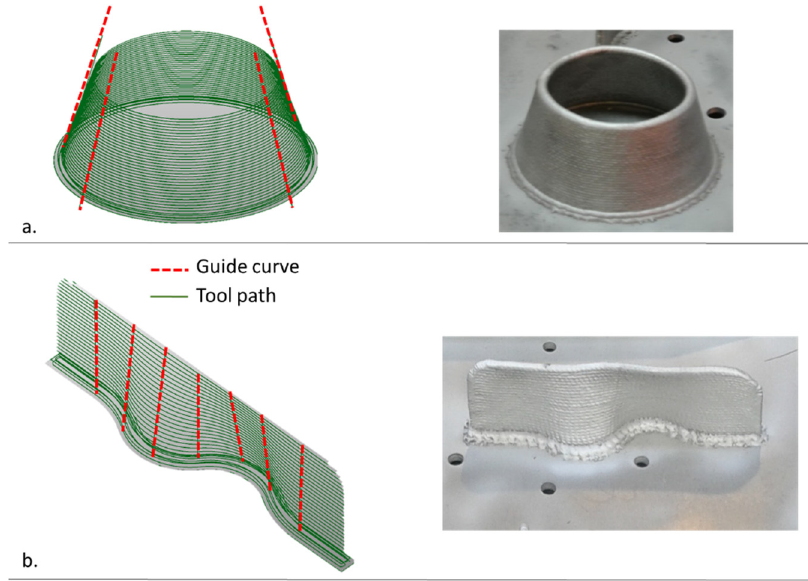
Figure 6. Tool path generation with guide curves to orient two axes: ( a ) 15° cone and ( b ) variable inclination wall.